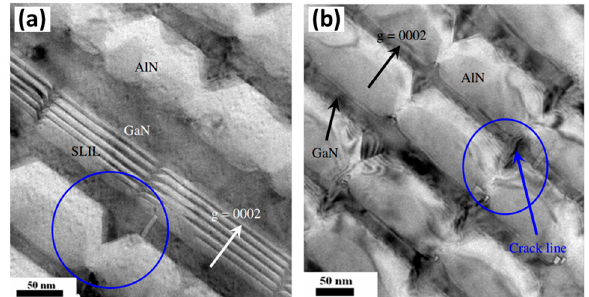
Figure 5. A chart depicting different approaches to prepare DBRs toward the fabrication of III-nitride VCSEL devices. The corresponding sections of review are labeled at the